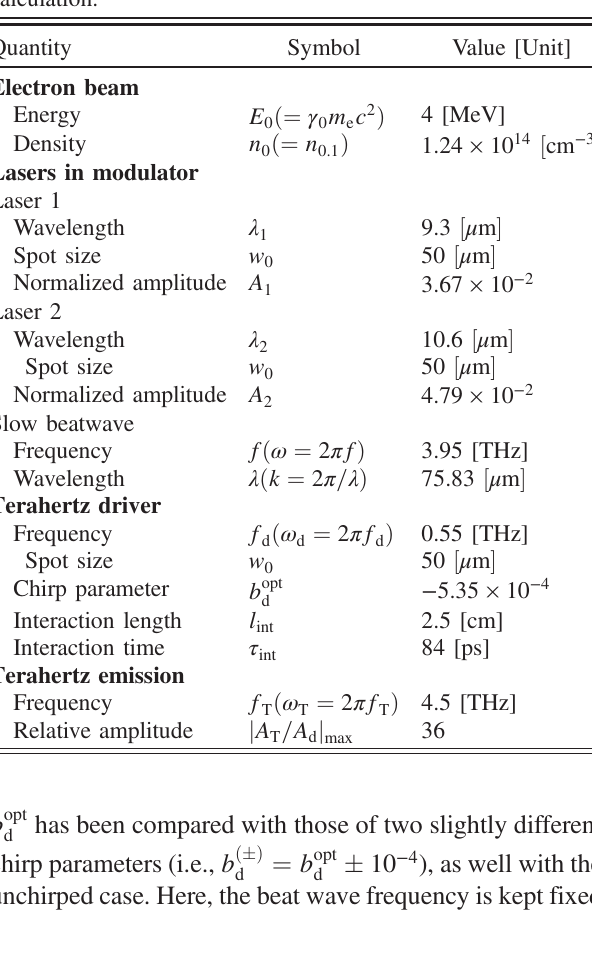
ð(cid:4)Þ ¼ b opt (cid:4) d d